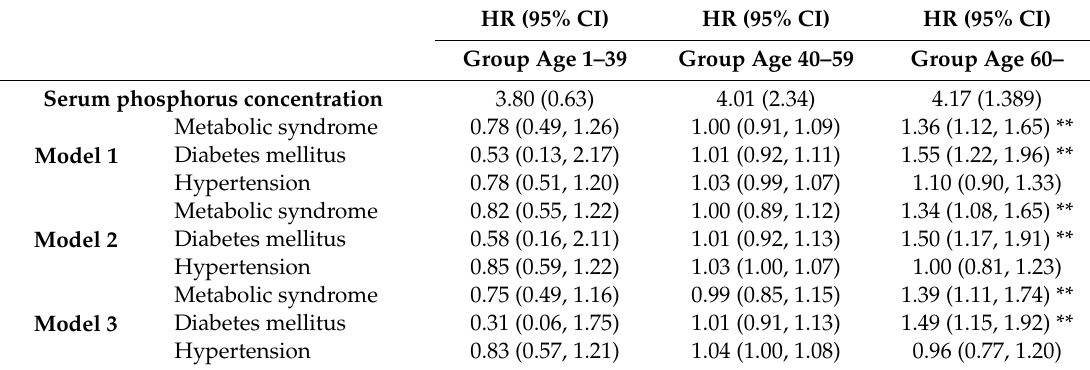
Table 2. Hazard ratios of serum phosphorus level for metabolic syndrome, diabetes mellitus, and